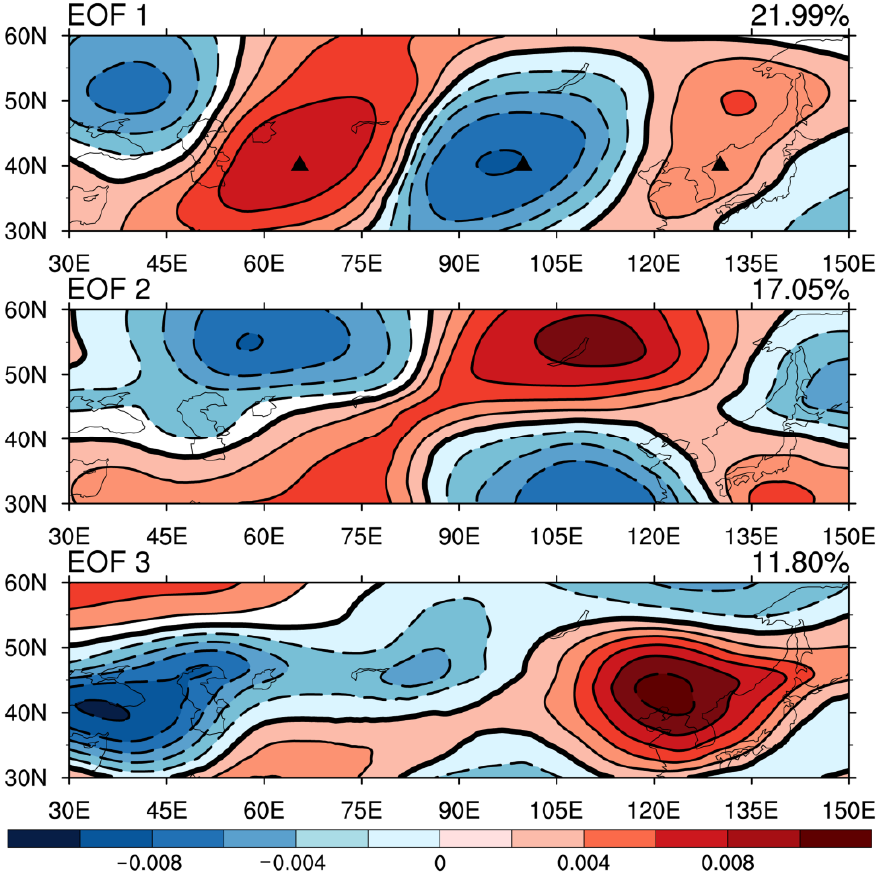
Figure 1. The preceding three EOF modes of daily 200 hPa normalized height anomalies along the Asian jet region (30–150° E, 30–60° N) during the summertime (June–August) of 1979 to 2020. Solid and dashed contours in EOF1 mode denote the positive and negative values, respectively (with interval of 0.002). The triangles represent the three basic points in Equation (1).